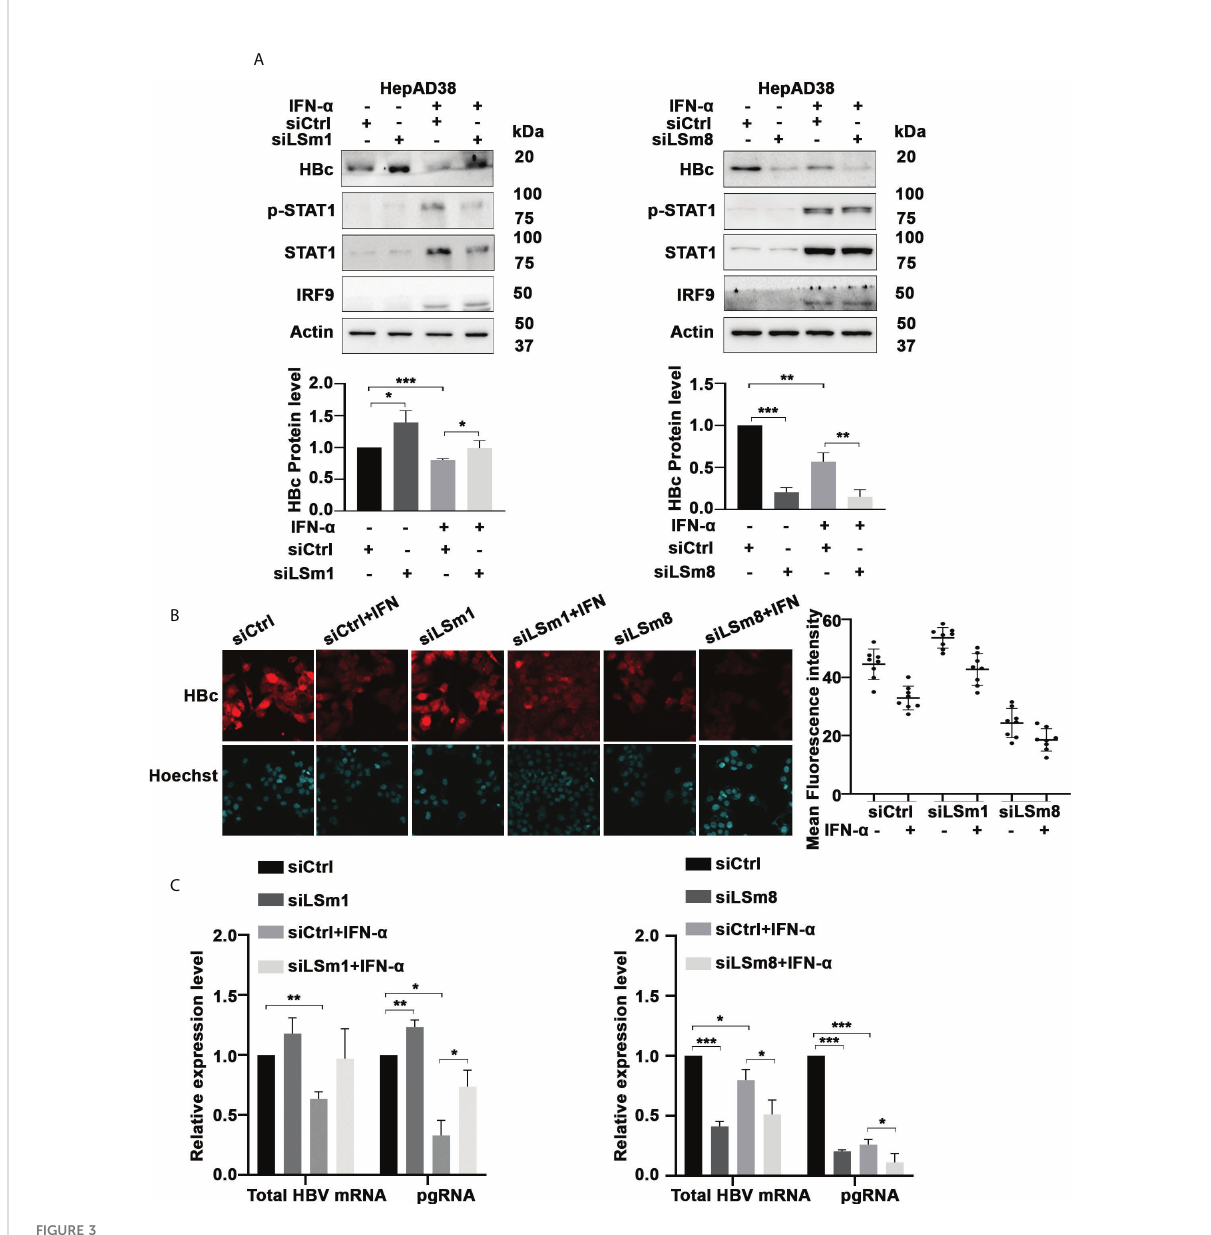
FIGURE 3 Role of Lsm complexes in HBV biosynthesis and IFN- a response. (A) Immunoblot of indicated proteins using lysates of unsynchronized HepAD38 cells replicating HBV for 4 days by tetracycline removal, treated with (+) or without (-) IFN-a (400ng/ml) for 4 days. Transfection of 50pM each of control siRNA (siCtrl), LSm1 siRNA (siLSm1) or LSm8 (siLSm8) at onset of HBV replication (n=4). (Panels below) Quanti fi cation of immunoblots by ImageJ software. n=4, *p<0.05, ** p<0.01, ***p<0.001. (B) HBc immuno fl uorescene microscopy of unsynchronized HepAD38 cells grown as in (A) (Right Panel) Quanti fi cation of HBc immuno fl uorescence by Image J software. (C) qRT-PCR of total HBV RNA and preC/ pgRNA under conditions described in (A) . n=3, *p<0.05, ** p<0.01,